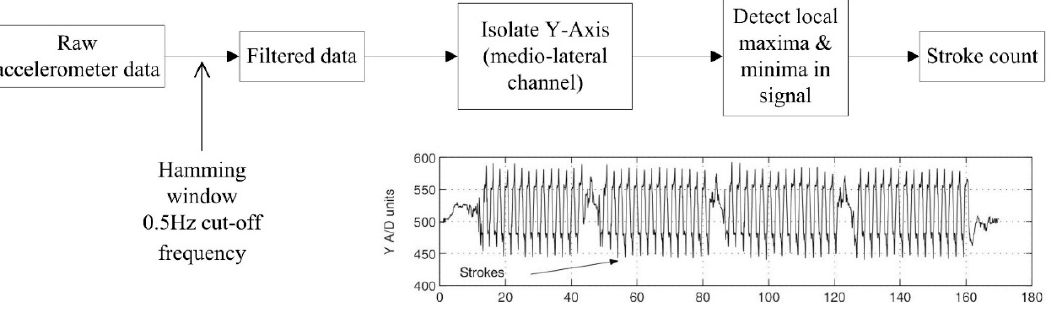
Figure 16. The regularly repeating pattern of swimming exhibited allows for a stroke count algorithm based on tracking peaks and troughs in the acceleration signal. Reproduced with permissions from Davey, Anderson and James [11].